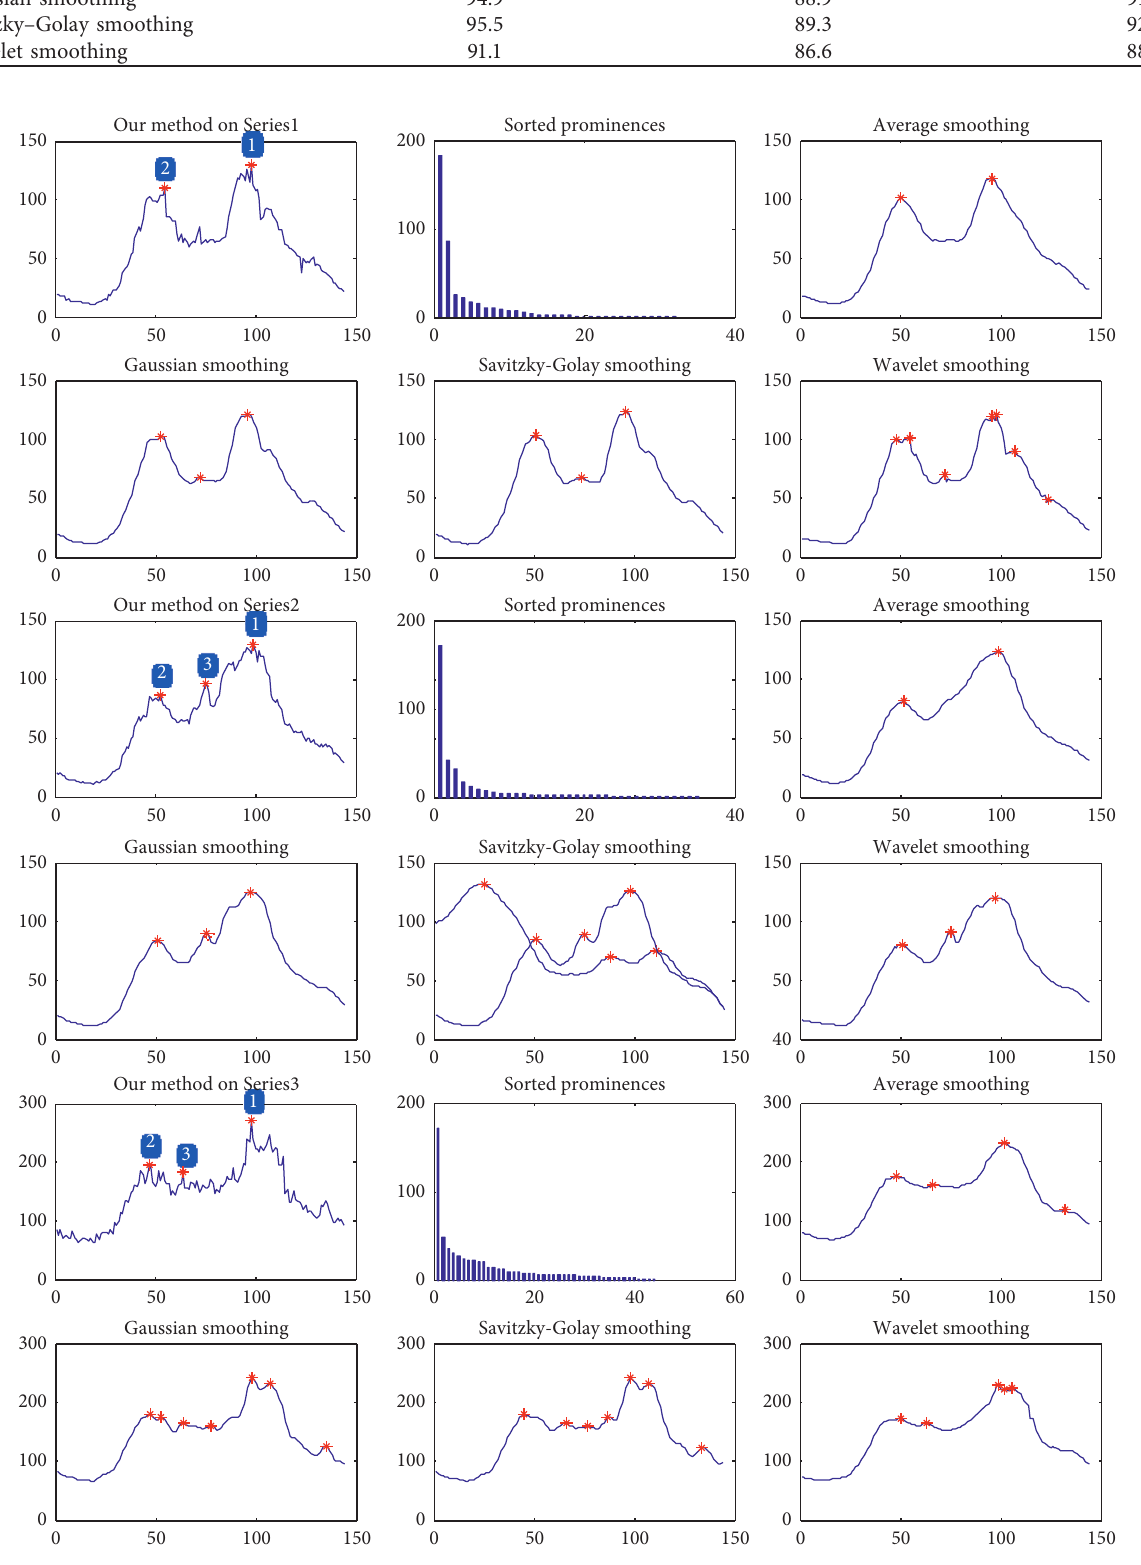
Figure 21: The detected peaks on 3 series by our method and the smoothing-based methods with a best parameter (as listed in Table 4). For each series, the sorted prominences are also depicted. The peaks by our method are marked and labeled on the raw data, and the peaks by the smoothing methods are marked on the smoothed